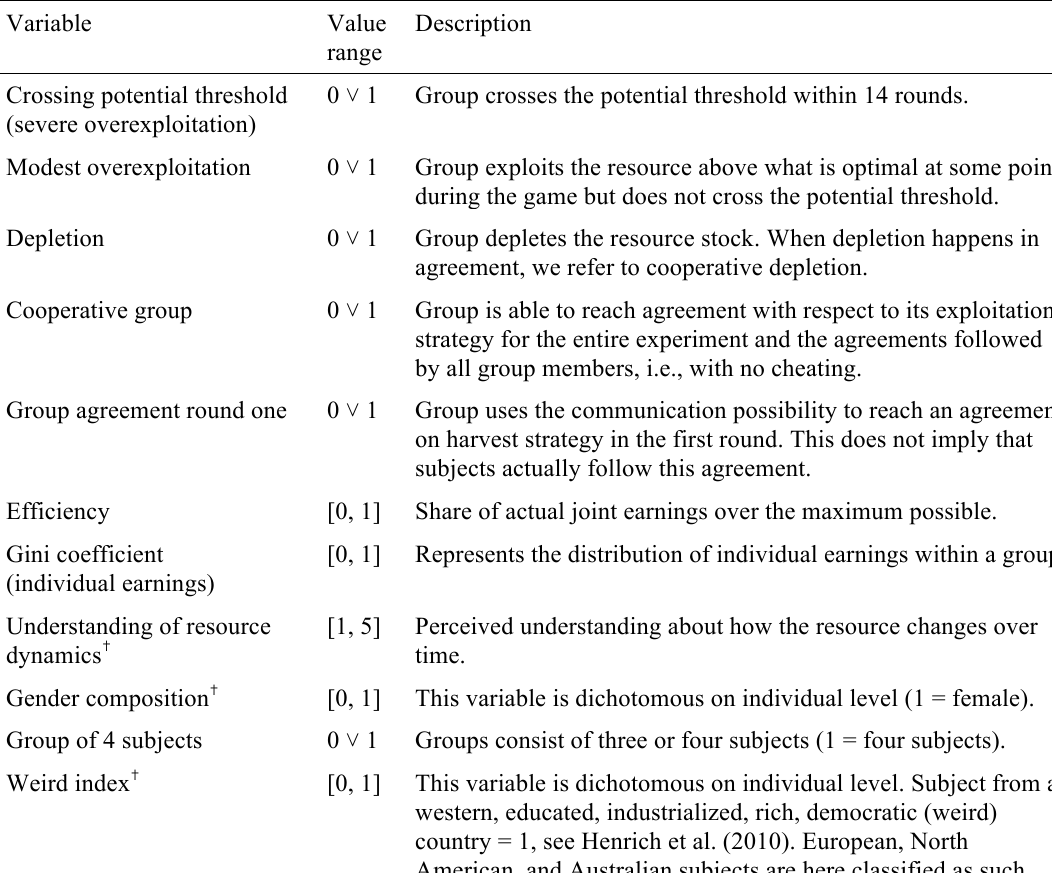
Table A3.1. Description of variables used for analysis. All variables display (mean) group